Question: Summarize what this figure shows in one sentence.
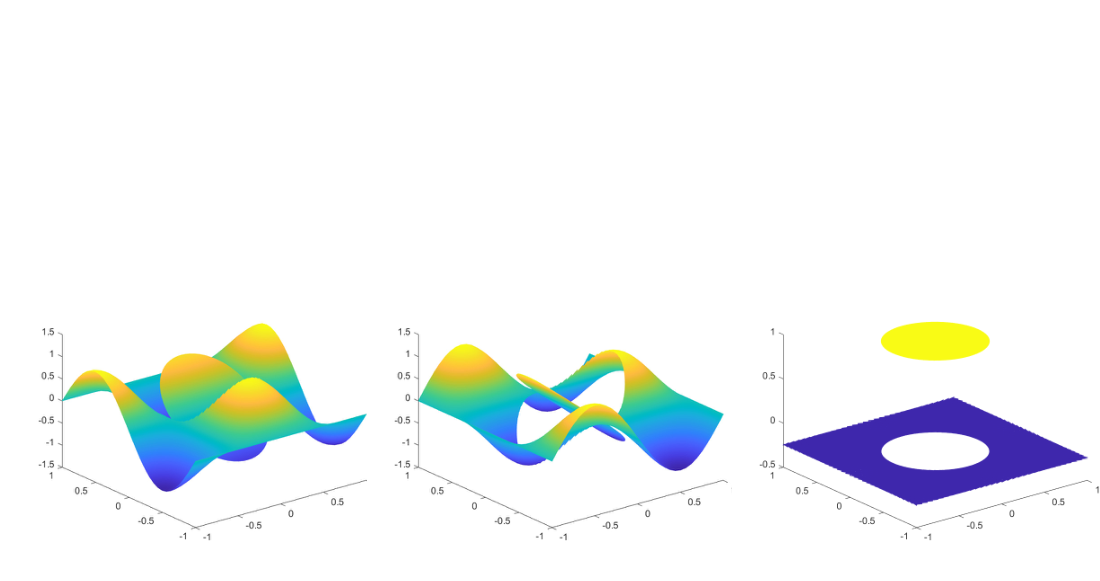
Answer: The numerical solutions by P2 WG element on curved triangular meshes level 3 in Example 7.1. Left: The first component of uh. Middle: The second component of uh. Right: Pressure function ph.